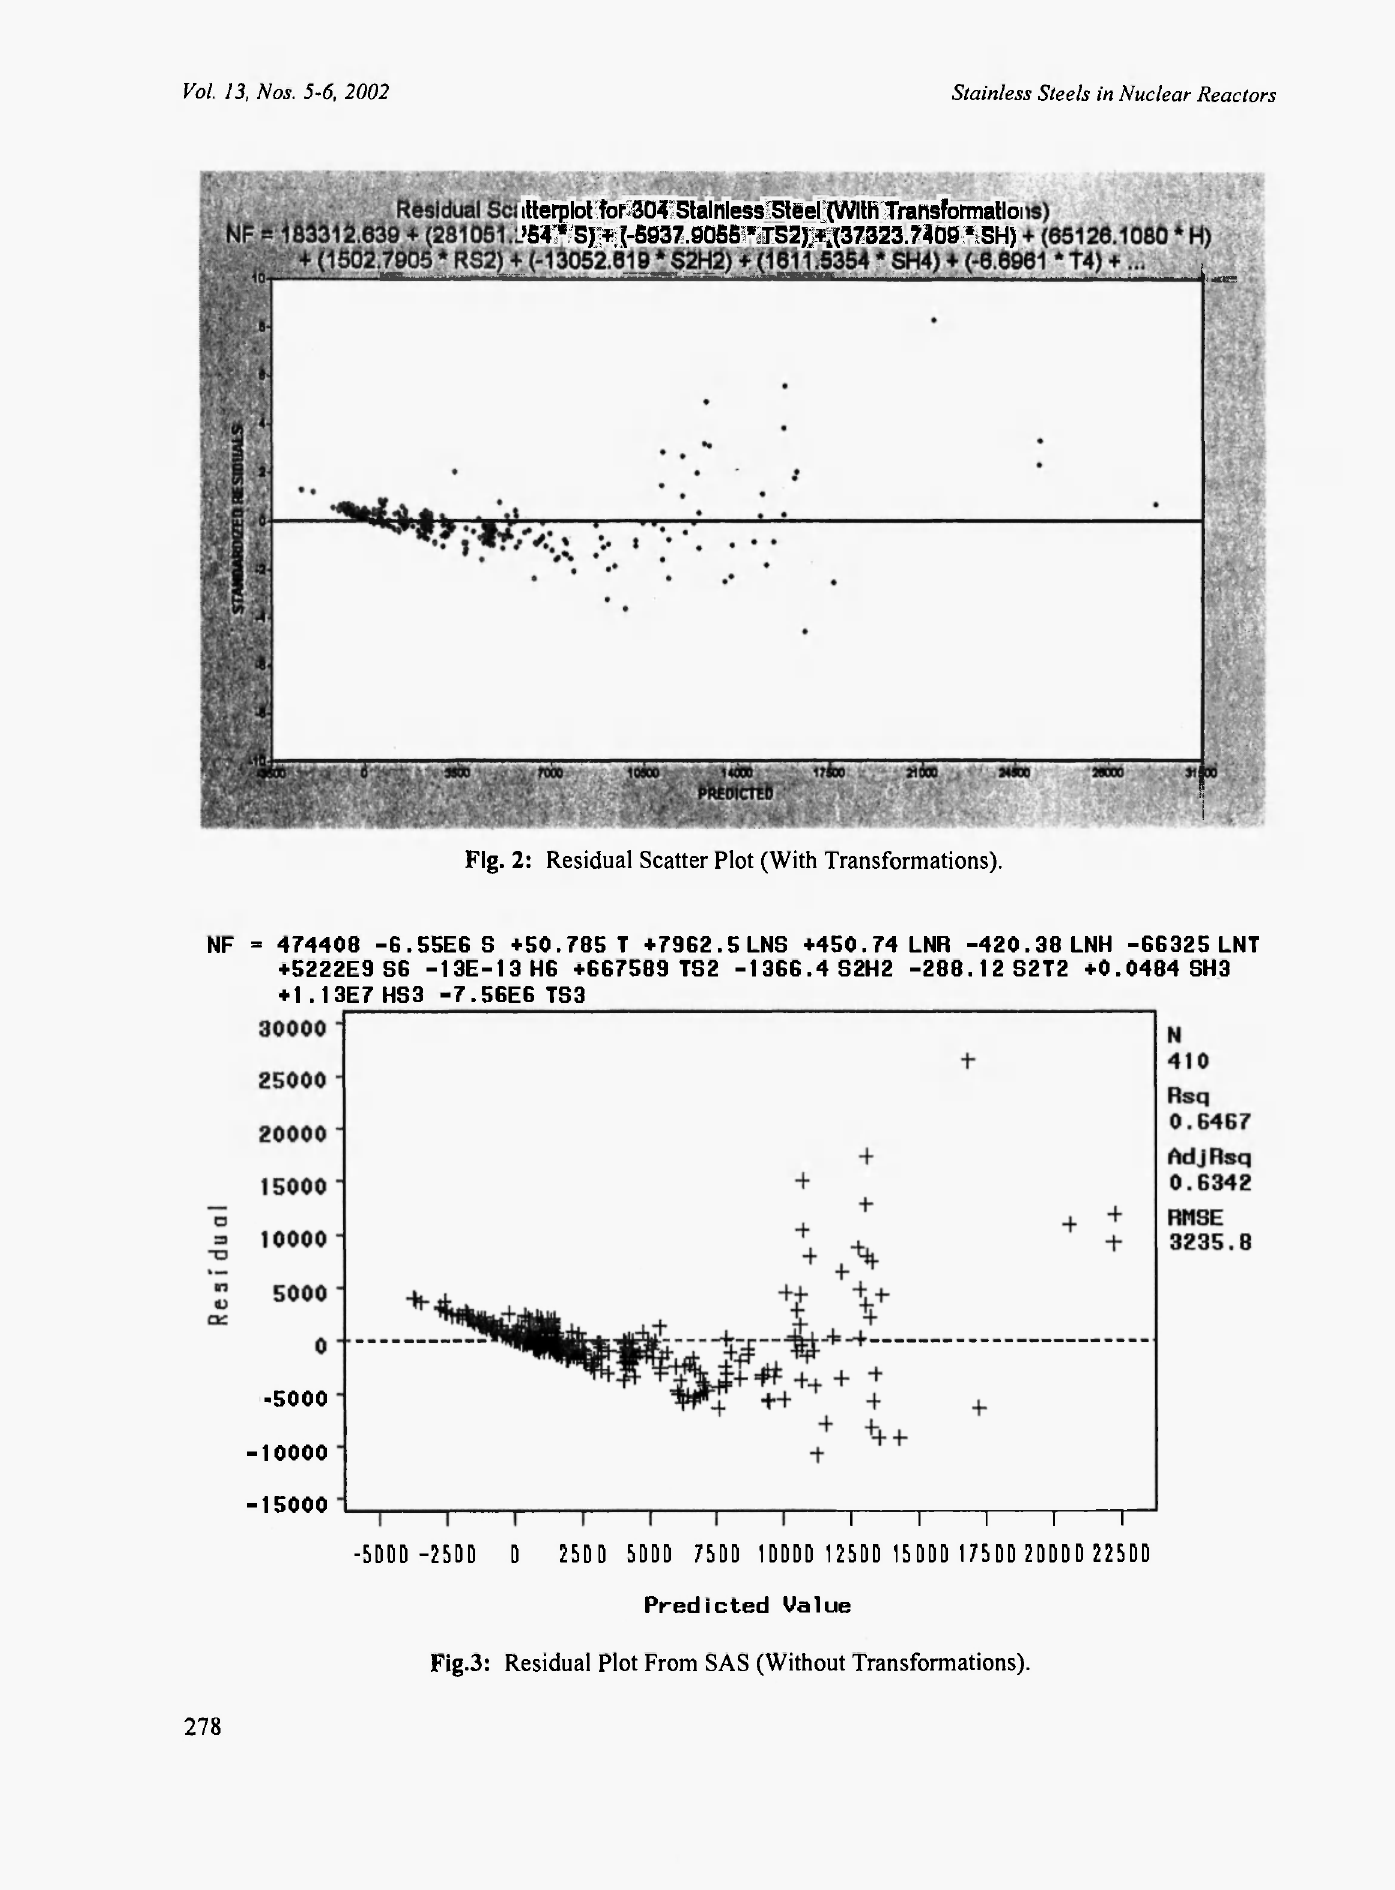
Fig.3: Residual Plot From S AS (Without